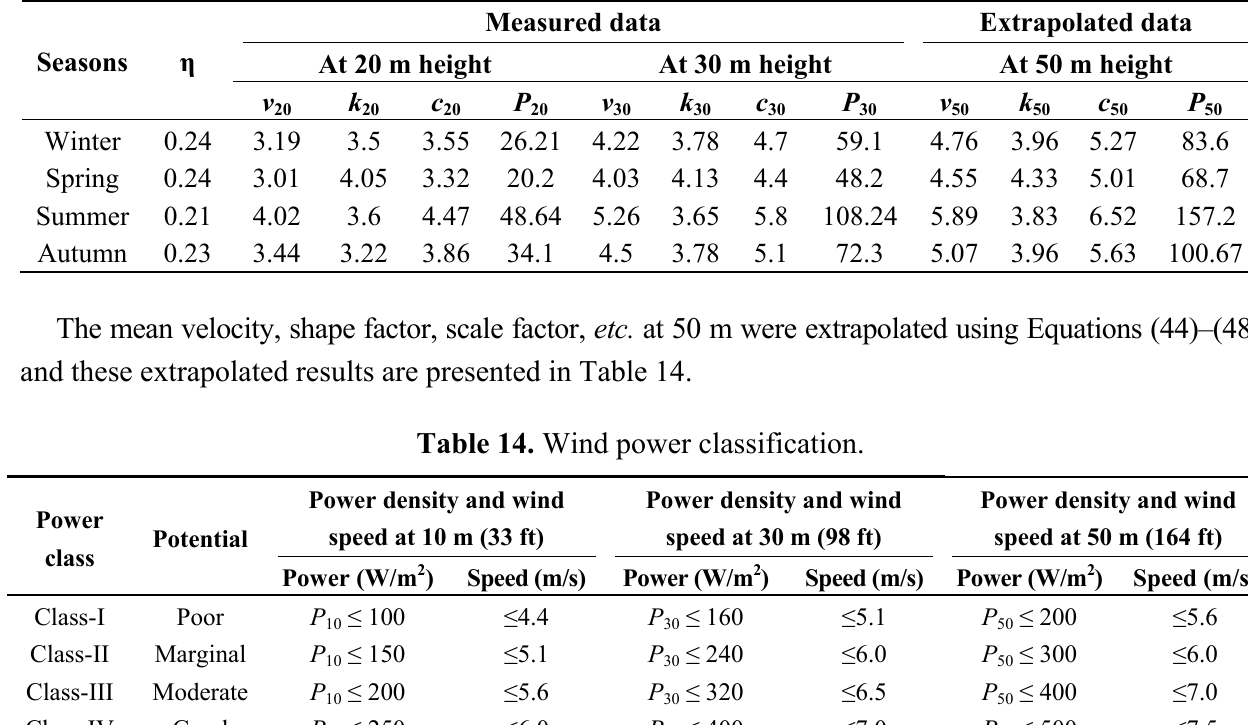
Table 13. Seasonal mean wind speed in (m/s), the Weibull shape factor (-), scale factor (m/s) and power density (W/m 2 ) at 30 m and 50 m